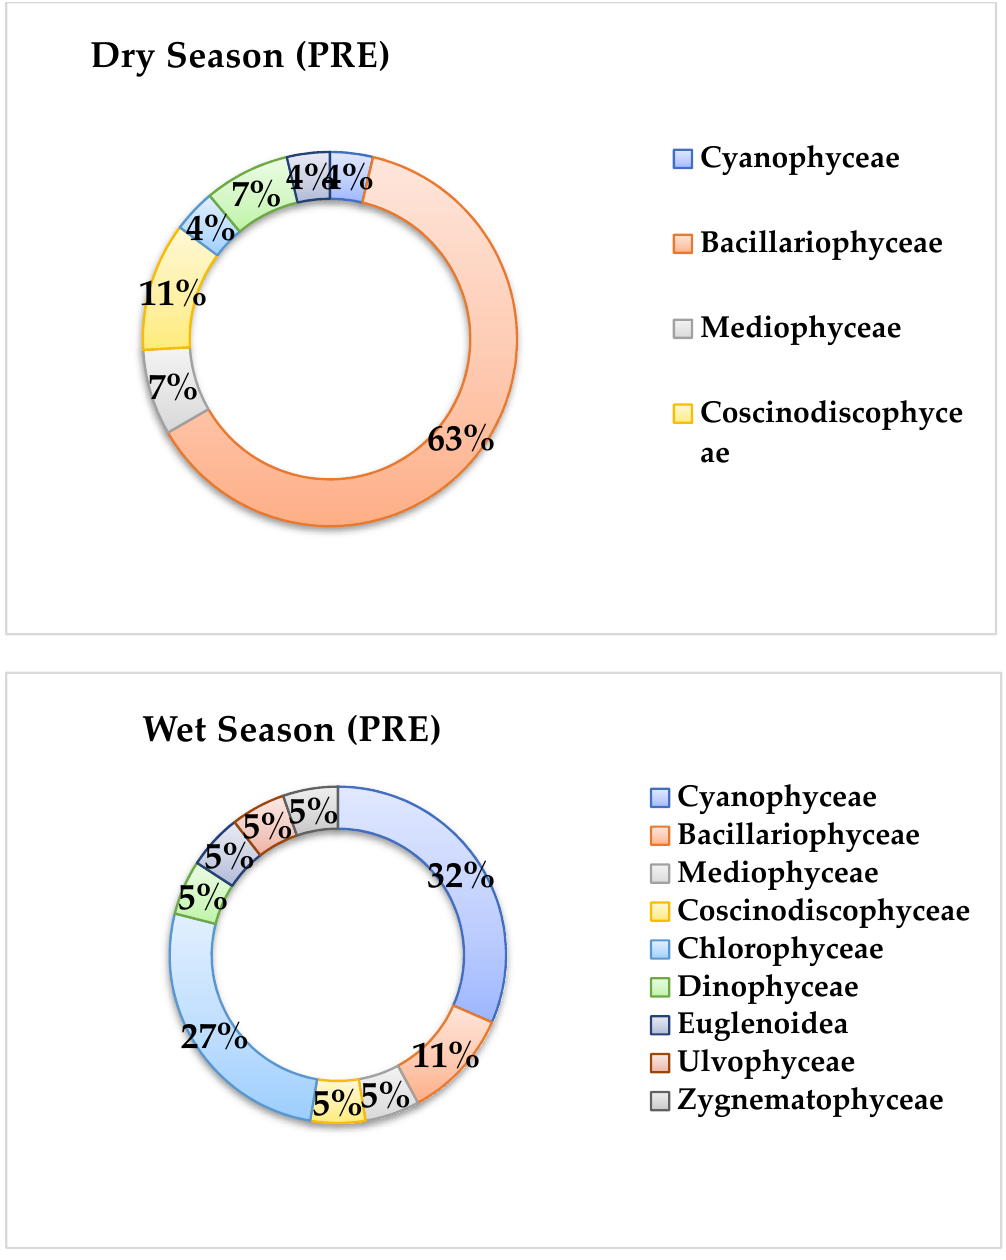
Figure 4. Percentage composition of phytoplankton during the dry and wet seasons in the mangrove creeks.